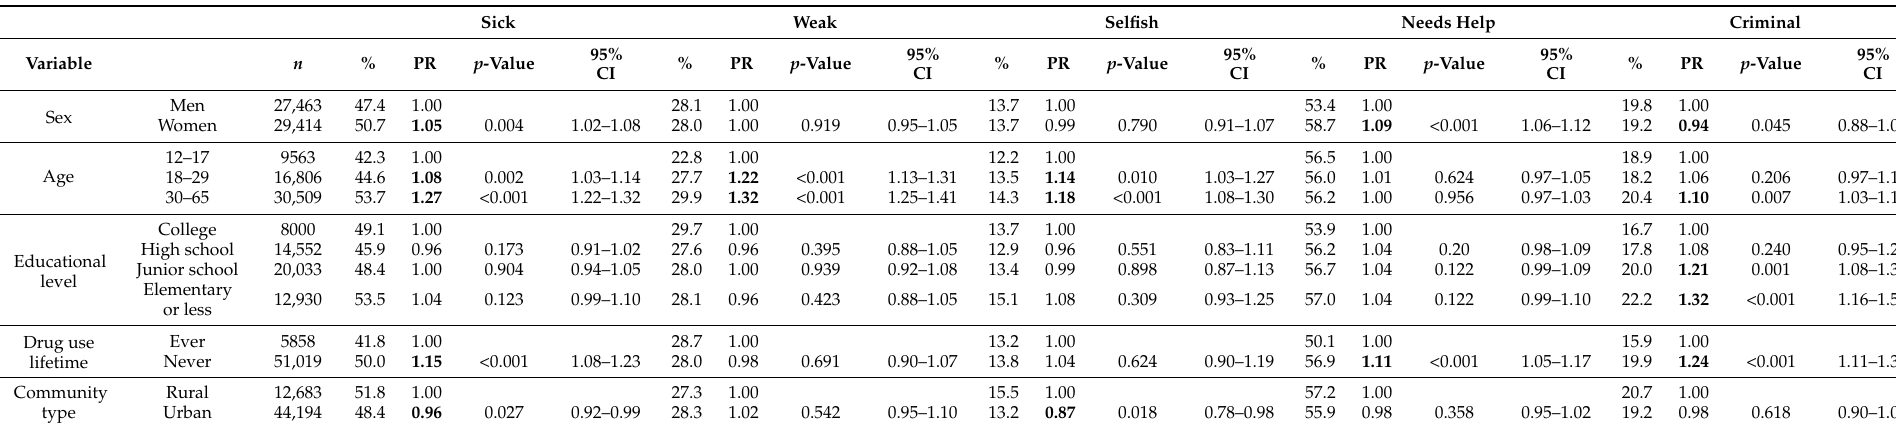
Table 3. Attitudes toward persons with substance use disorder in the 2016 household survey: prevalence ratio model. Sick Weak Selfish Needs Help